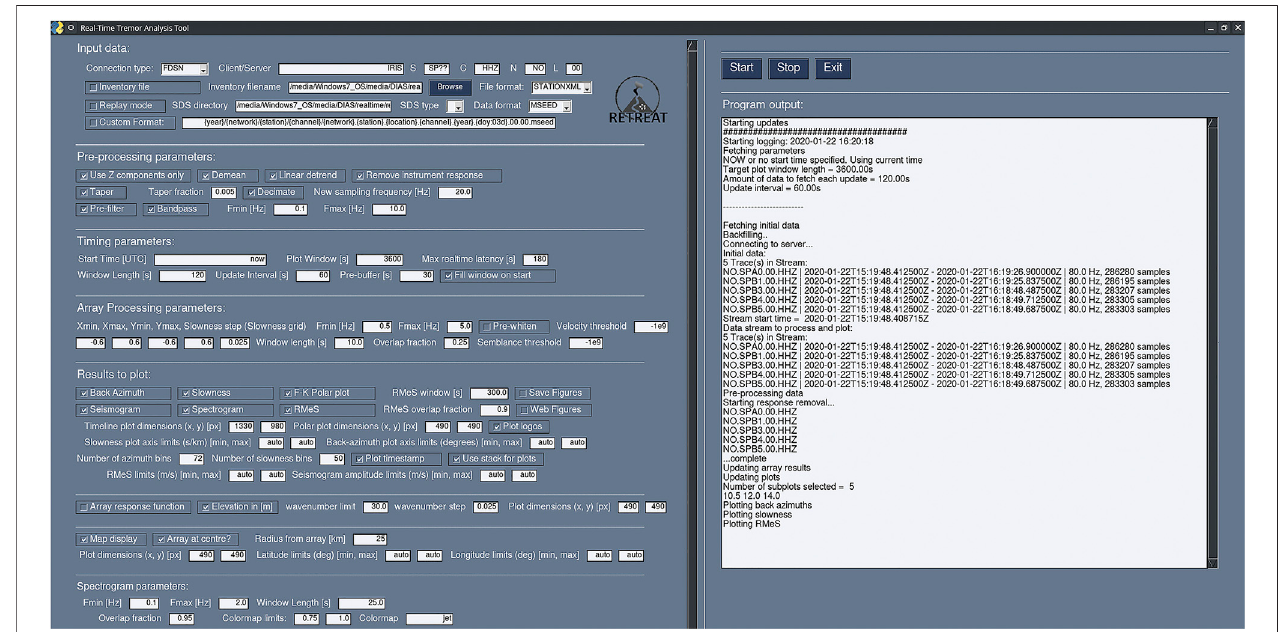
FIGURE 2 | Example screenshot of the GUI interface for the RETREAT tool, showing the program controls, con fi gurable input parameters and program output window.